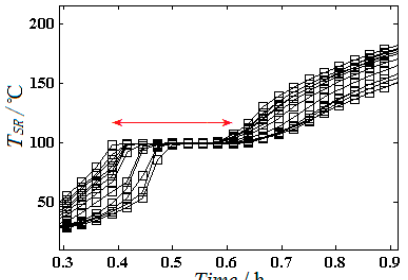
Figure 4. Temperature variation at different measurement points in the reforming channel between 0.3 and 0.9 h.